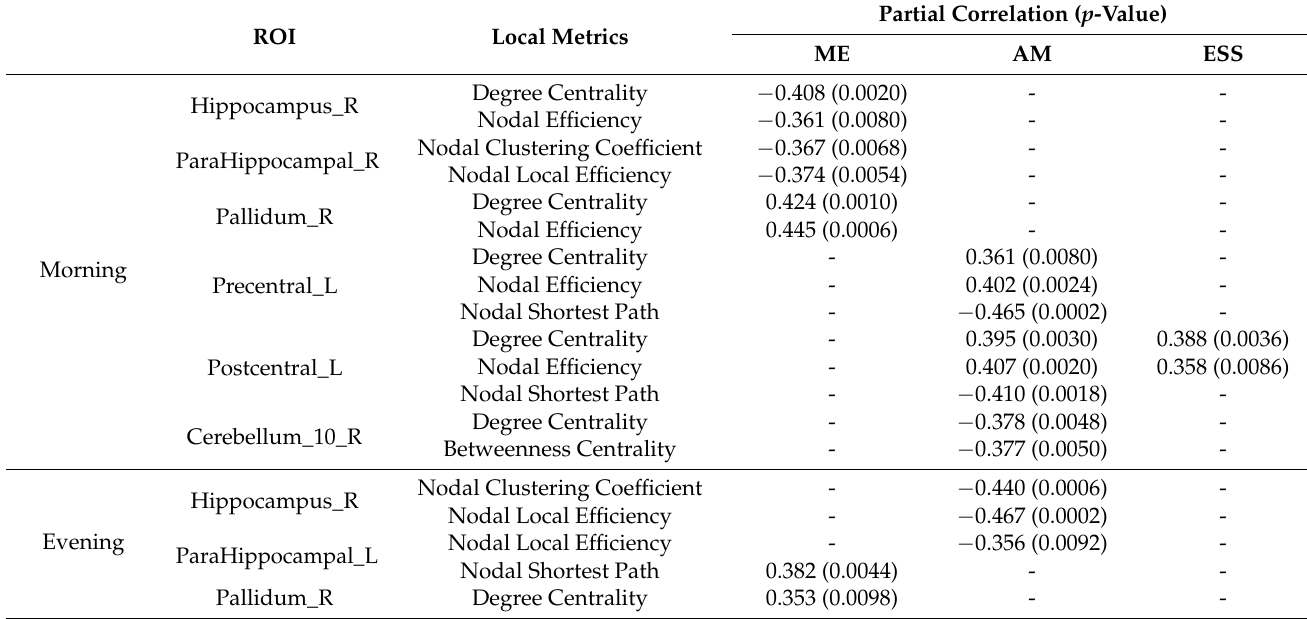
Table 4. Partial correlations between nodal metrics with ME, AM, and ESS scores ( n = 62; significance level was set at p < 0.01 and p -values were adjusted for the Bonferroni correction). Partial Correlation ( p ROI Local Metrics